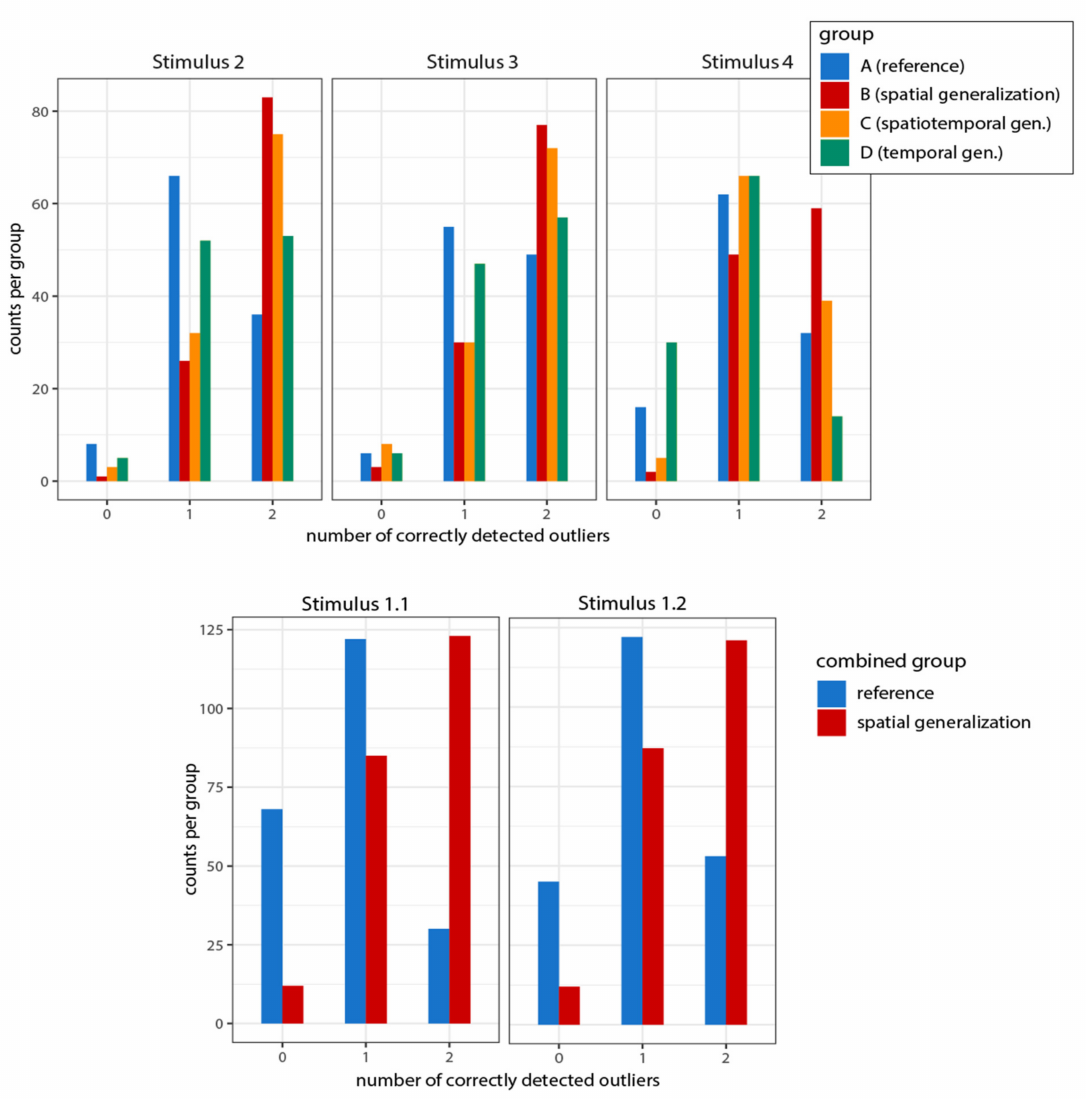
Figure 7. Number of persons per group/generalization type for correctly detecting none, one, or both local outliers in each